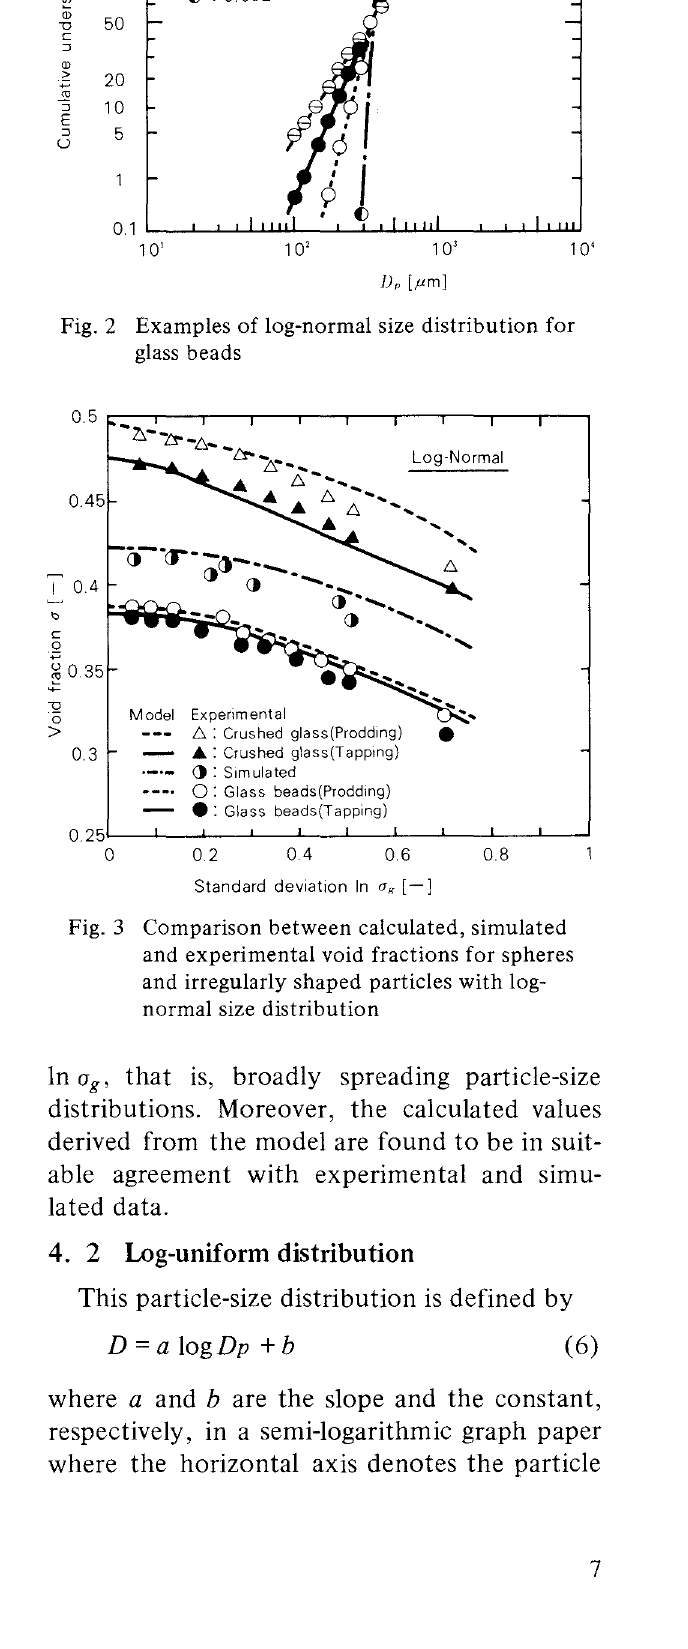
Fig. 2 Examples of log-normal size distribution for glass beads